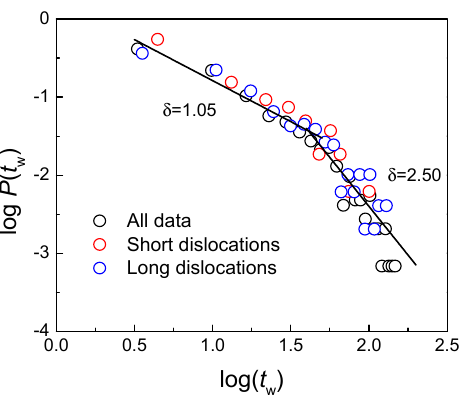
Figure 6. Double power-law distribution of waiting times between successive jerks induced by short dislocation (red), long dislocations (blue) and all (black).